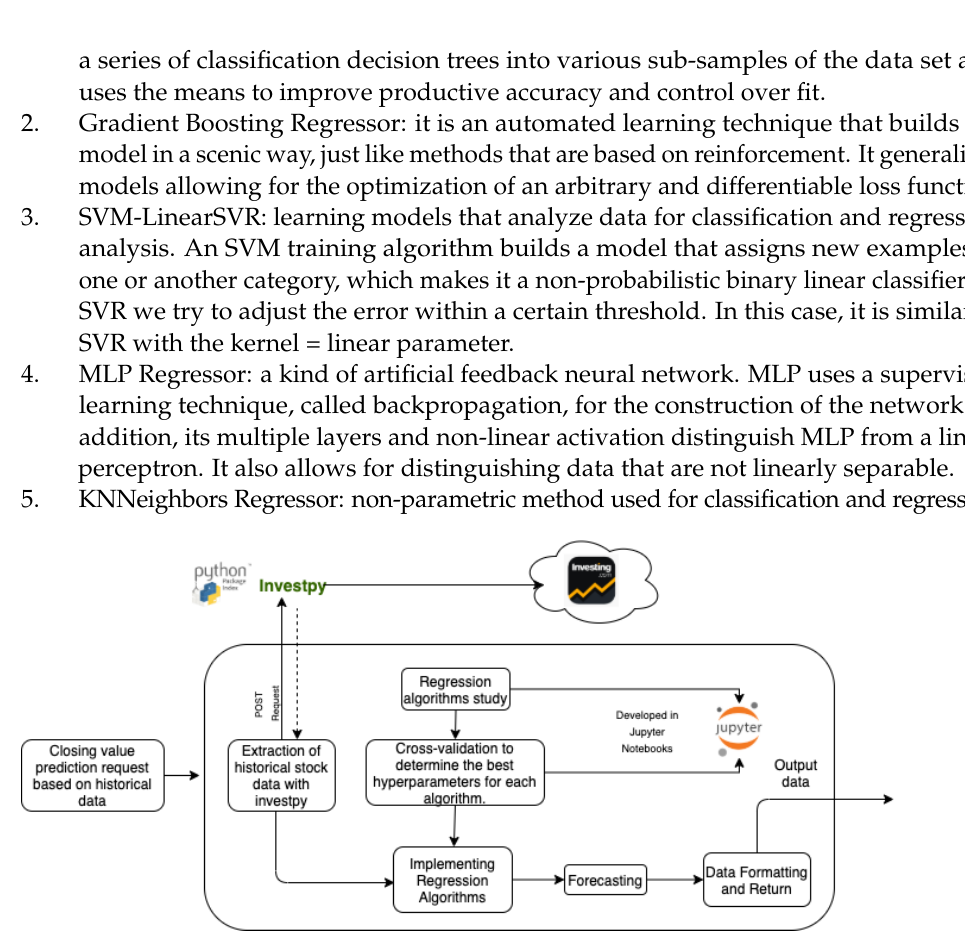
Figure 6. Forecasting System Package Design Specification.